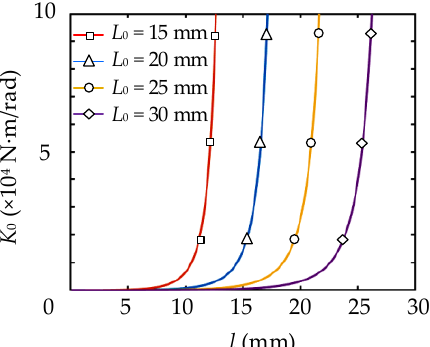
Figure 10. Stiffness curves near the initial state at different values of L 0 .